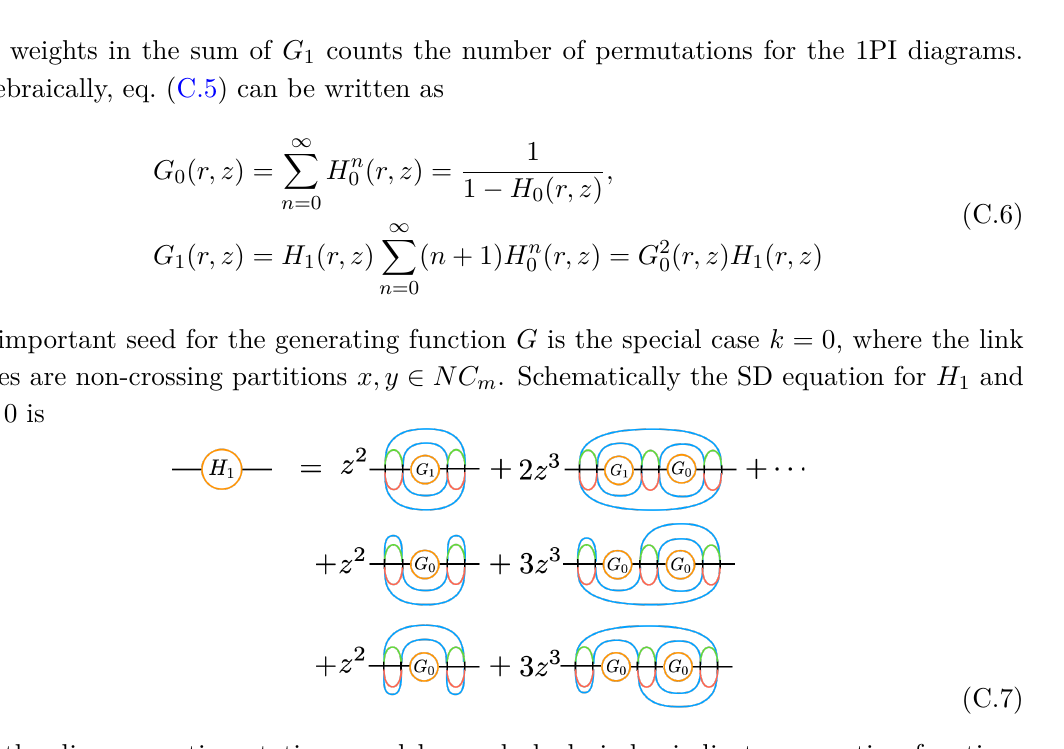
For the diagrammatic notations used here: dashed circles indicate generating functions such as G ( r, z ) and H ( r, z ) ; and solid line circles indicate the generating functions for the k = 0 sector, i.e. G (0 , z ) and H (0 , z ) . In the last two rows the blue connections